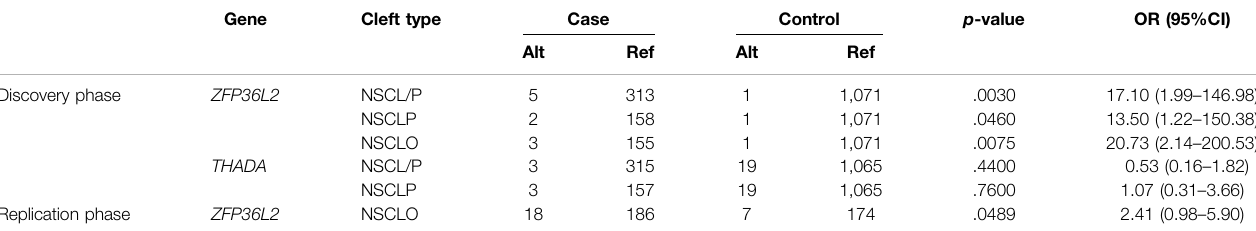
TABLE 2 | Burden analysis of rare variants in 2p21 locus.